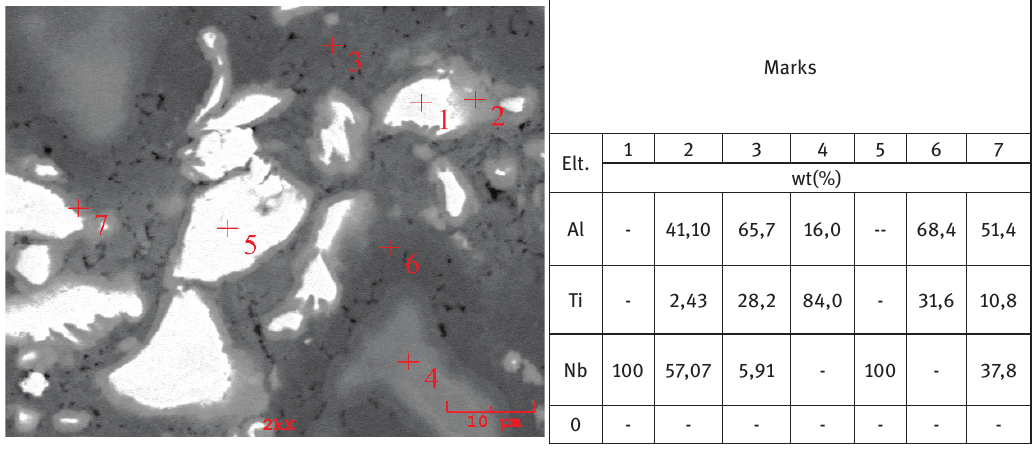
Figure 6: EDS Analyses of C3 Sample.